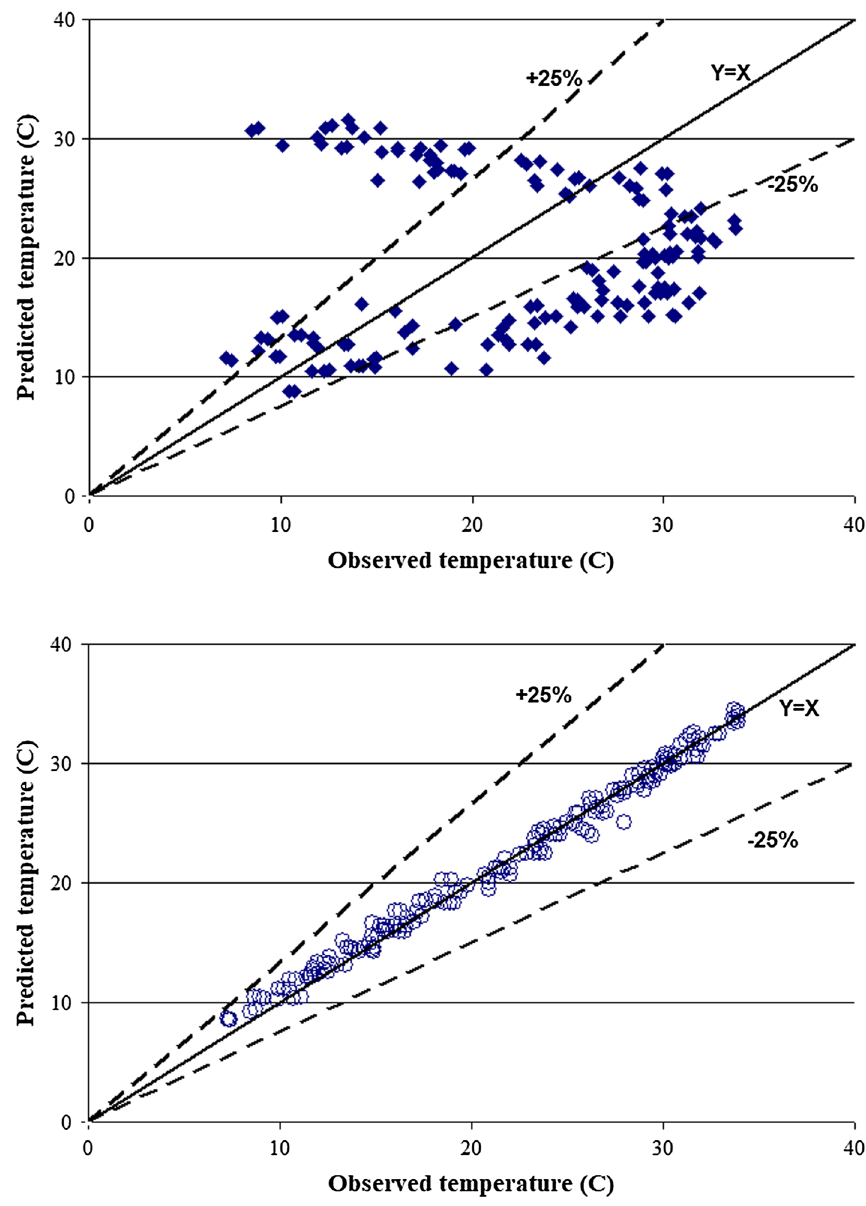
Fig. 2 Predicted temperature using ANN against the observed temperature